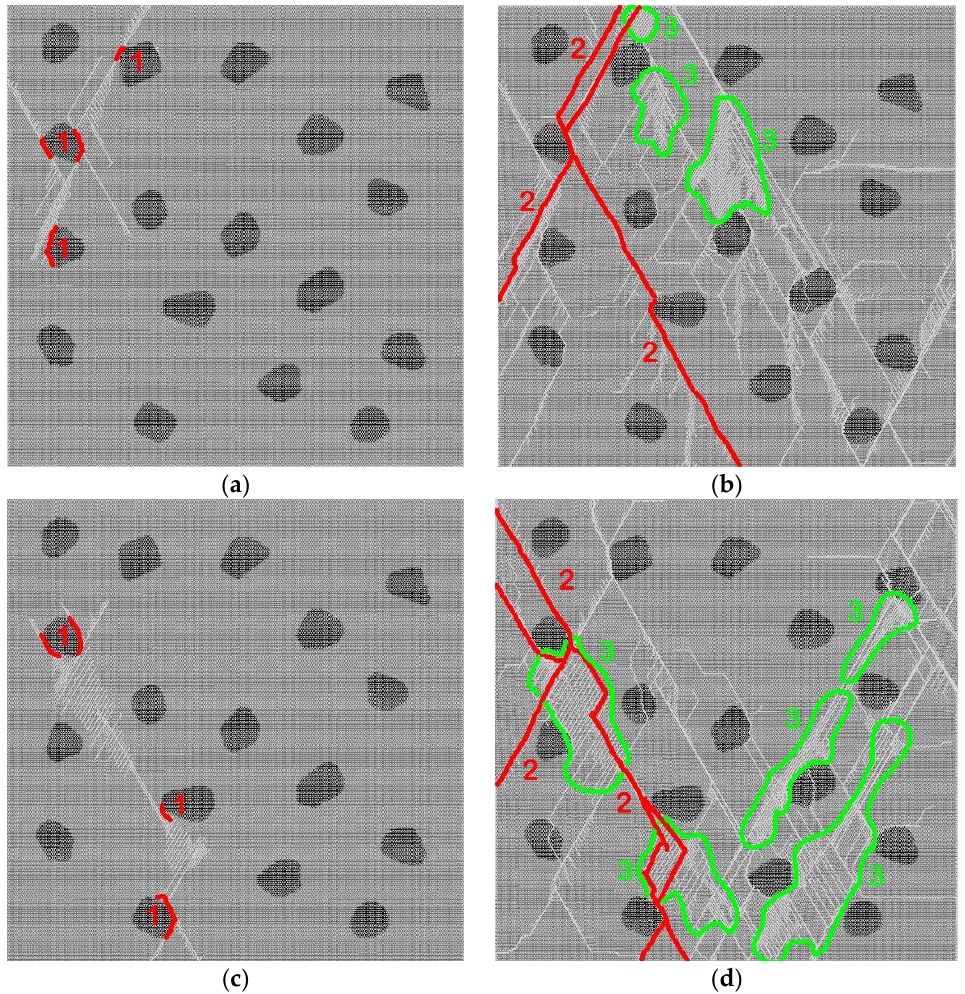
Figure 4. Fracture of model water-saturated concrete samples with capillary pores at different values of Da : 0.5 ( а , b ); 140 ( c , d ). Figures ( a,c ) show the beginning phase of fracture, while figures ( b,d ) show broken samples. Primary (interfacial) damages in ( a , c ) are marked by the red lines and indicated by the number 1. The main cracks (first destructive cracks) in ( b , d ) are marked by the red line and indicated by the number 2. The cleavage zones are bordered by green contours and indicated by the number 3.